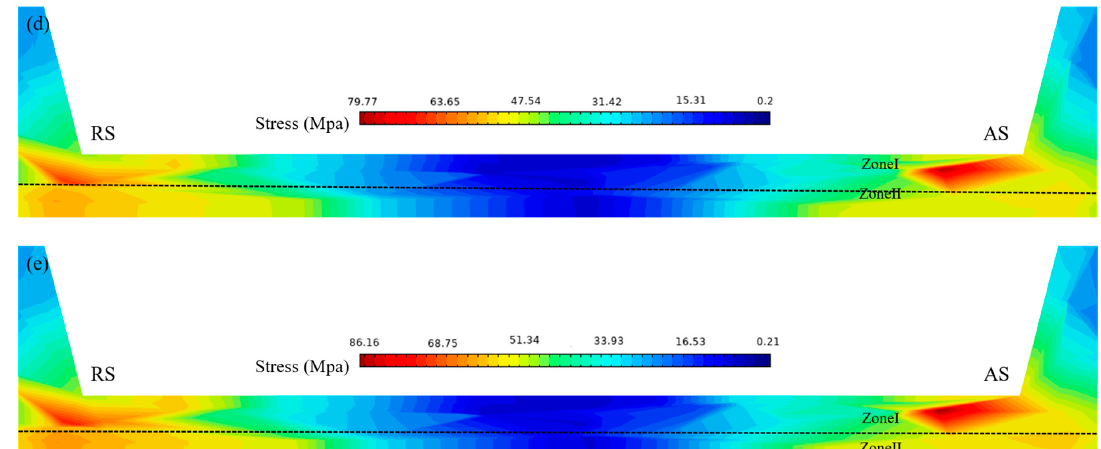
Figure 20. Distribution of shear stress at the root of the joint at different temperatures. ( a ) No. 1; ( b ) No. 2; ( c )